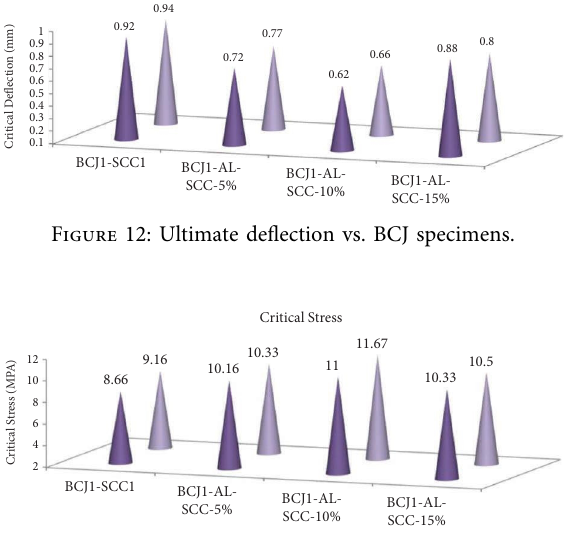
Figure 13: Ultimate stress vs. BCJ